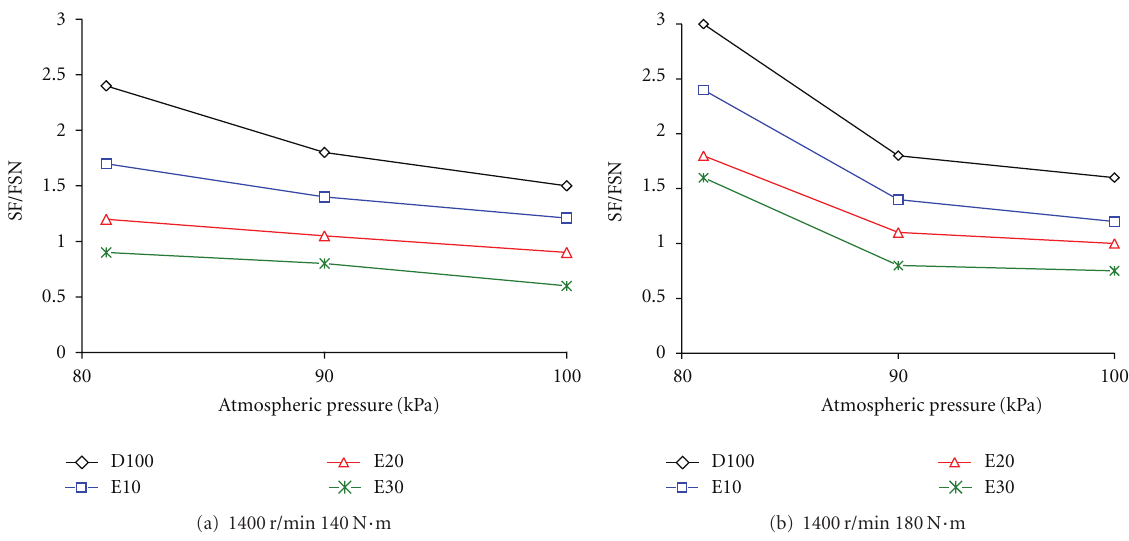
Figure 11: Comparison of smoke of di ff erent atmospheric pressure and mix proportion at speed 1400 r/min.